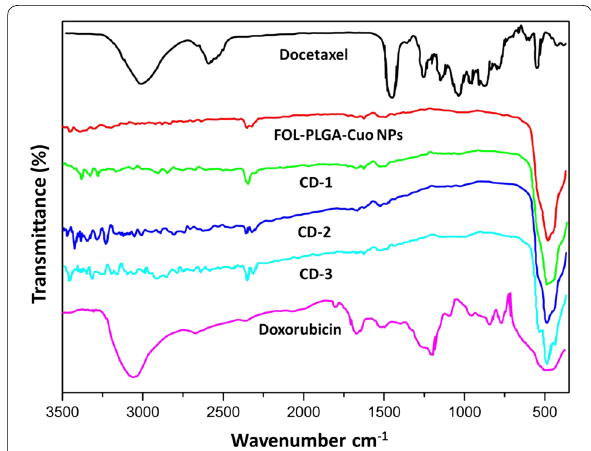
Fig. 4 FTIR Spectra of free docetaxel, doxorubicin, CuO NPs, FOL‑PLGA‑CuO NPs, CD‑1, CD‑2 and CD‑3. No new or drastic changes are seen in the spectra of CD‑1, CD‑2 or CD‑3 which may indicate a change in function